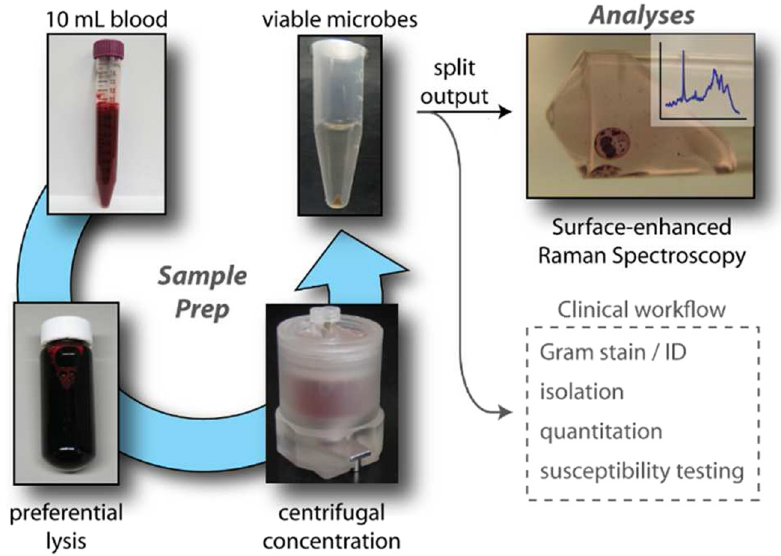
Figure 13: Technology overview for viable microberecoveryfromhumanblood.10mLof whole blood is processed to produce a 200- μ L output which is incubated brie fl y prior to surface enhanced Raman scattering (SERS) for identi fi cation or for integration into a standard clinical work fl ow. Reprinted